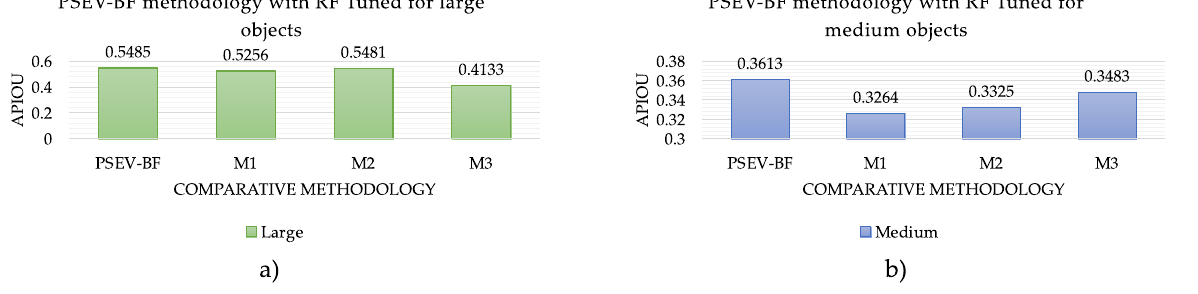
Figure 10. Results of the methodology compared with different configurations based on the APIoU metric for ( a ) large objects and ( b ) medium objects.